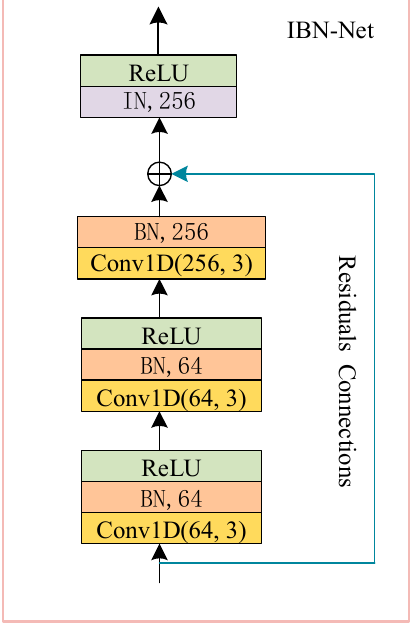
Figure 3. IBN-Net structure diagram.